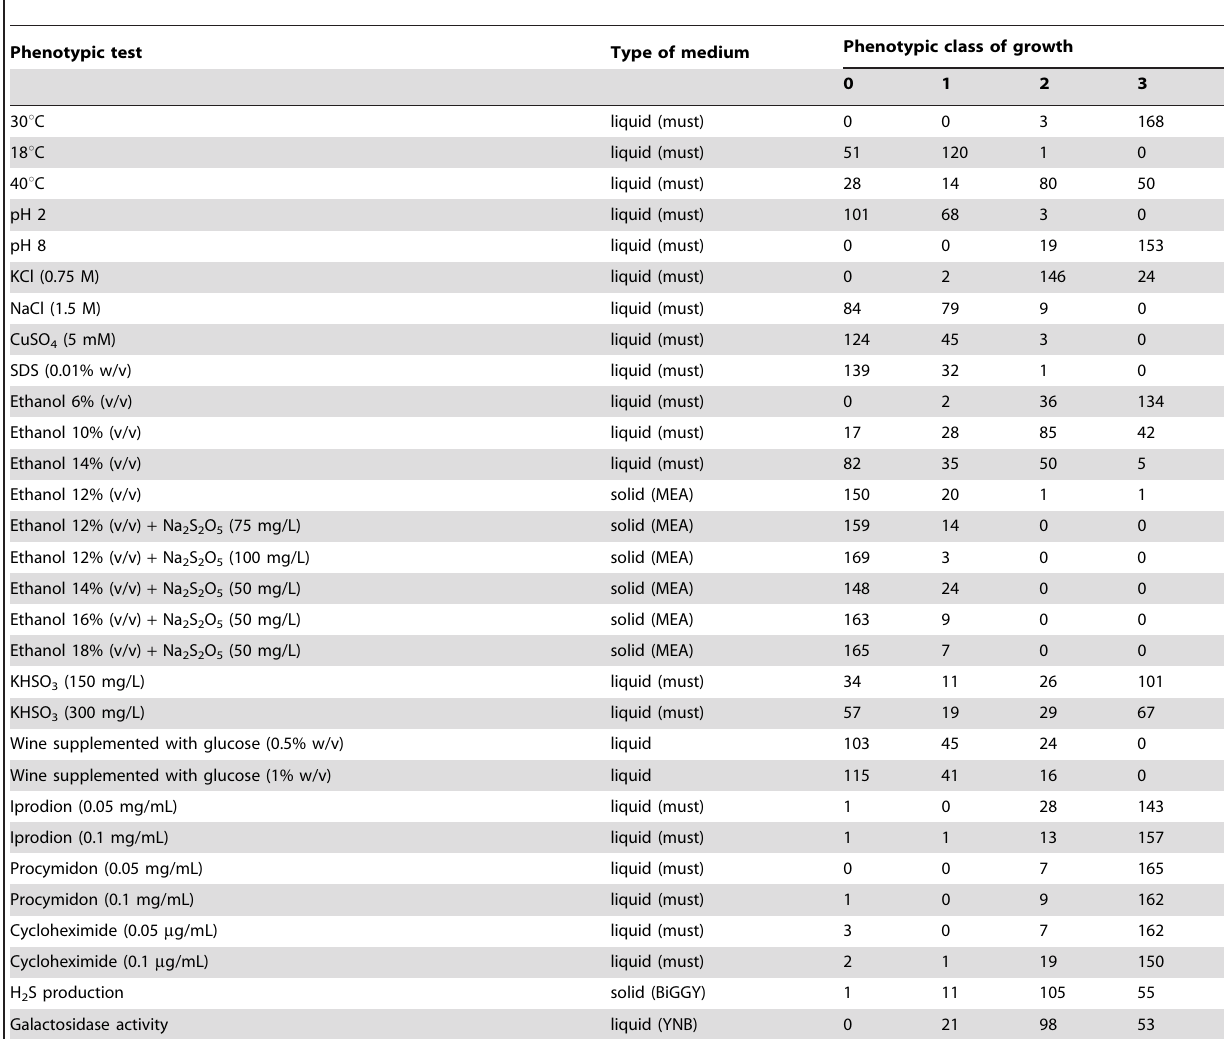
Table 1. Number of strains belonging to different phenotypic classes, regarding values of optical density (Class 0: A 640 =0.1; Class 1: 0.2 , A 640 . 0.4; Class 2: 0.5 , A 640 . 1.0; Class 3: A 640 . 1.0), growth patterns in solid media, or colour change in BiGGY